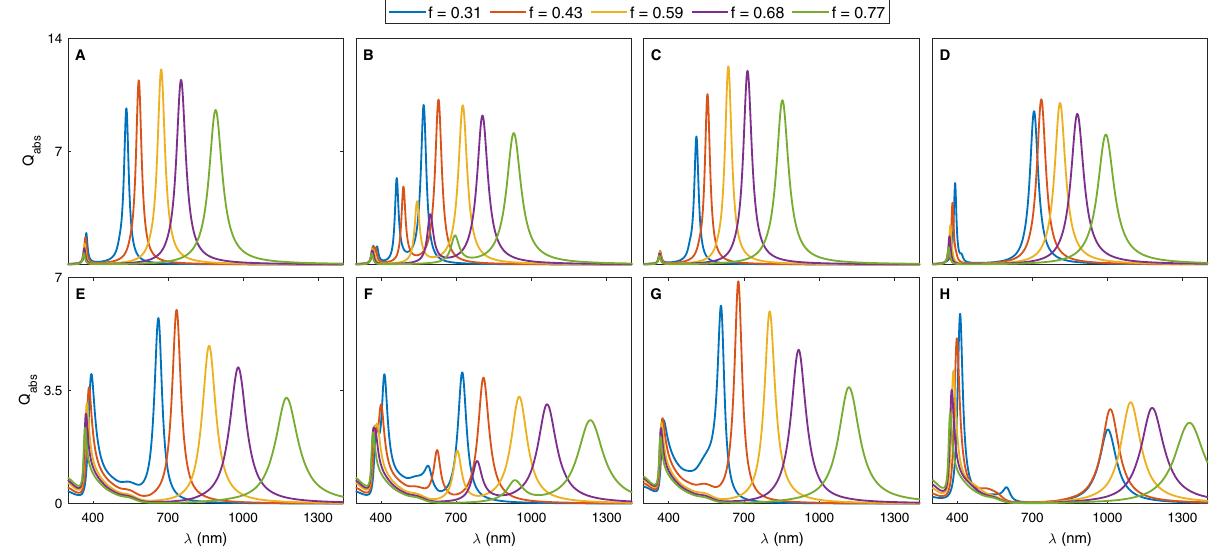
Figure 7. Absorption spectra of ( A – E ) CS, ( B – F ) NE, ( C – G ) PS and ( D – H ) OS configuration with different filling factors. Top panel: SiO 2 @ Au 0.5 Ag 0.5 . Bottom panel: Fe 2 O 3 @ Au 0.5 Ag 0.5 . The total radii of nanoshells are fixed at 25 nm. For Ps and OS, the major radii are 24